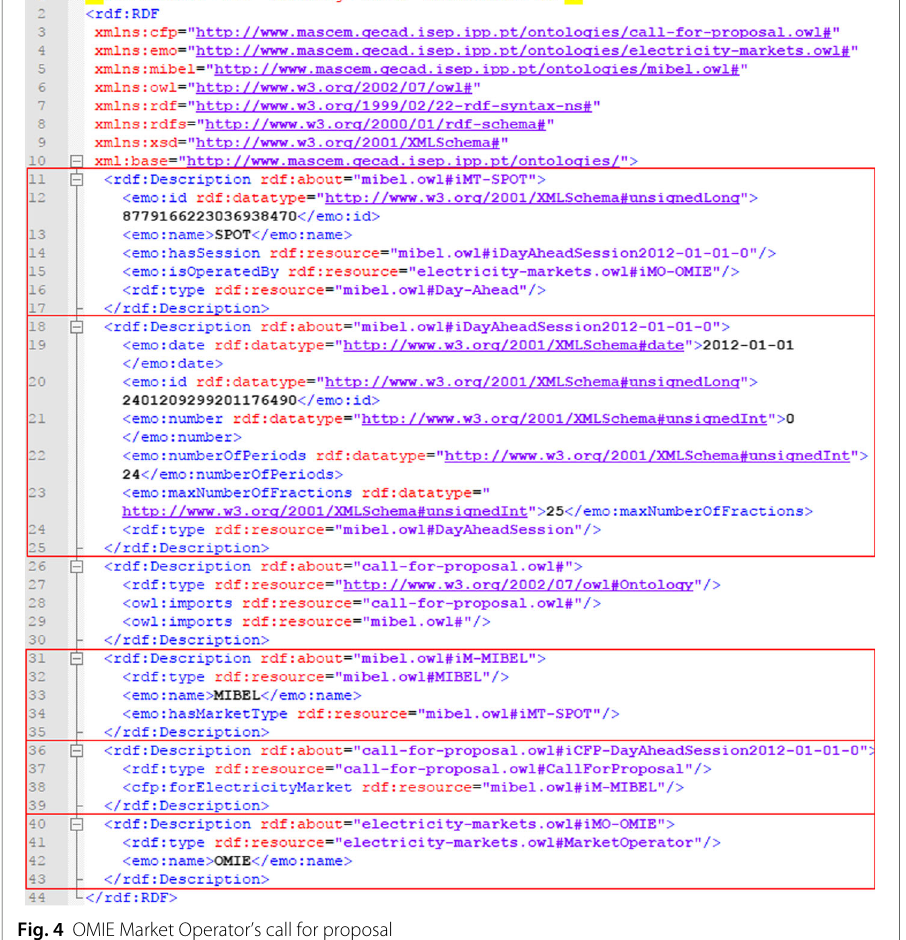
Fig. 4 OMIE Market Operator’s call for